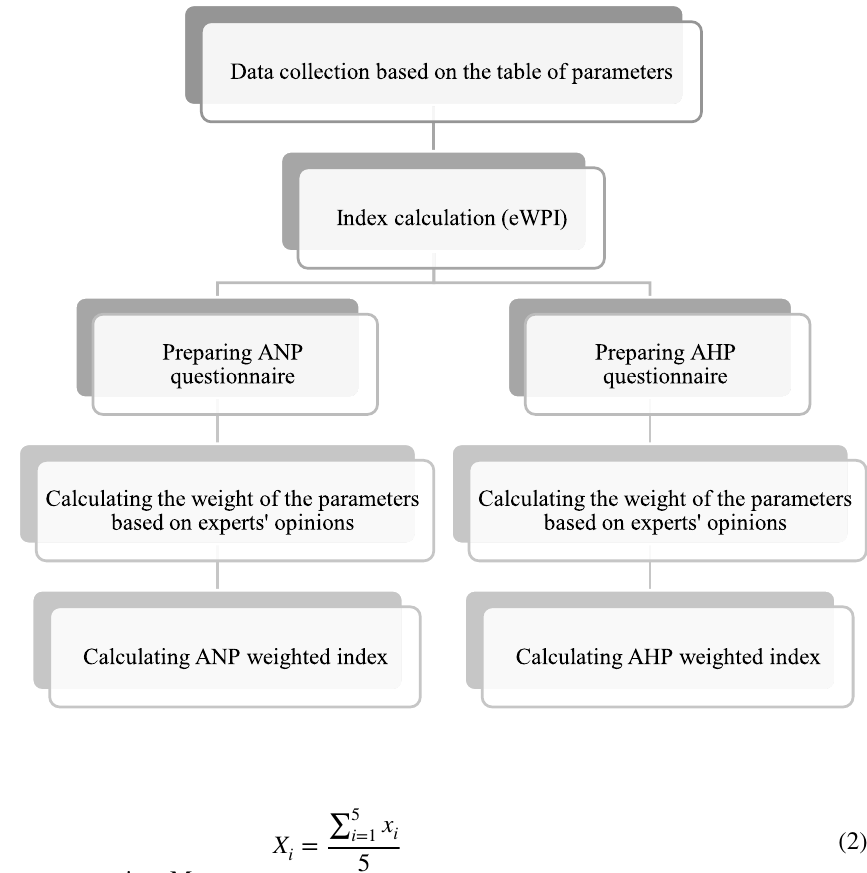
Fig. 2 The flowchart of